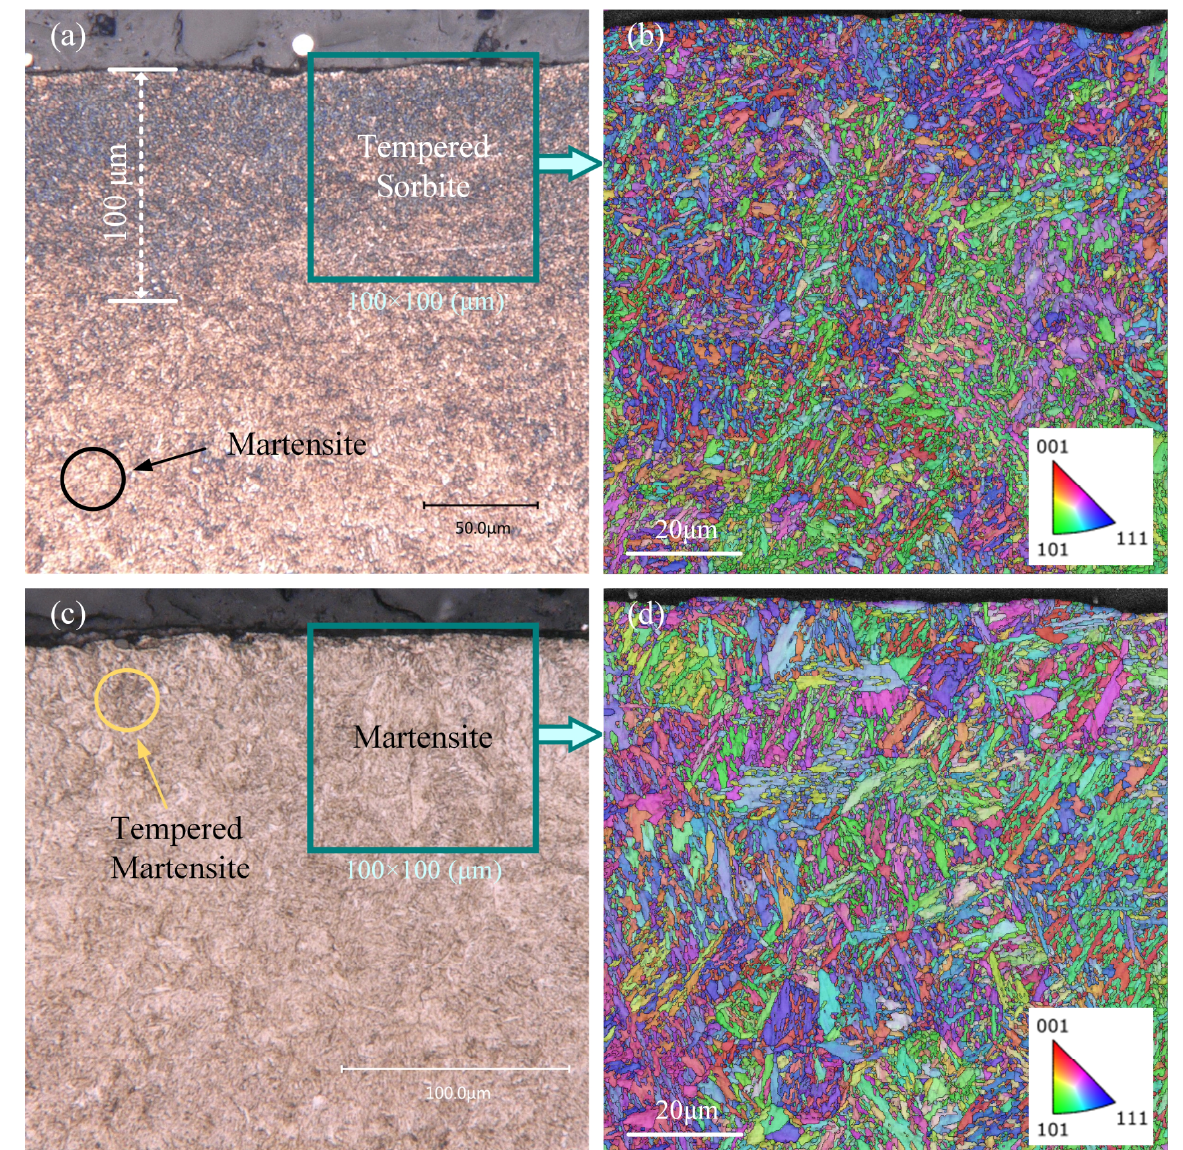
Figure 6. Metallographic and microstructure of the gear after grinding: ( a ) surface metallography of gears at a wheel speed of 15 m/s and a grinding depth of 25 µ m; ( b ) EBSD results of the surface microstructure of gears at a wheel speed of 15 m/s and a grinding depth of 25 µ m; ( c ) surface metallography of gears at a wheel speed of 30 m/s and a grinding depth of 5 µ m; ( d ) EBSD results of the surface microstructure of gears at a wheel speed of 30 m/s and a grinding depth of 5 µ m. To further elucidate the microstructure evolution caused by tempered grinding burns, the intergranular boundary angles were calculated from the grain orientation